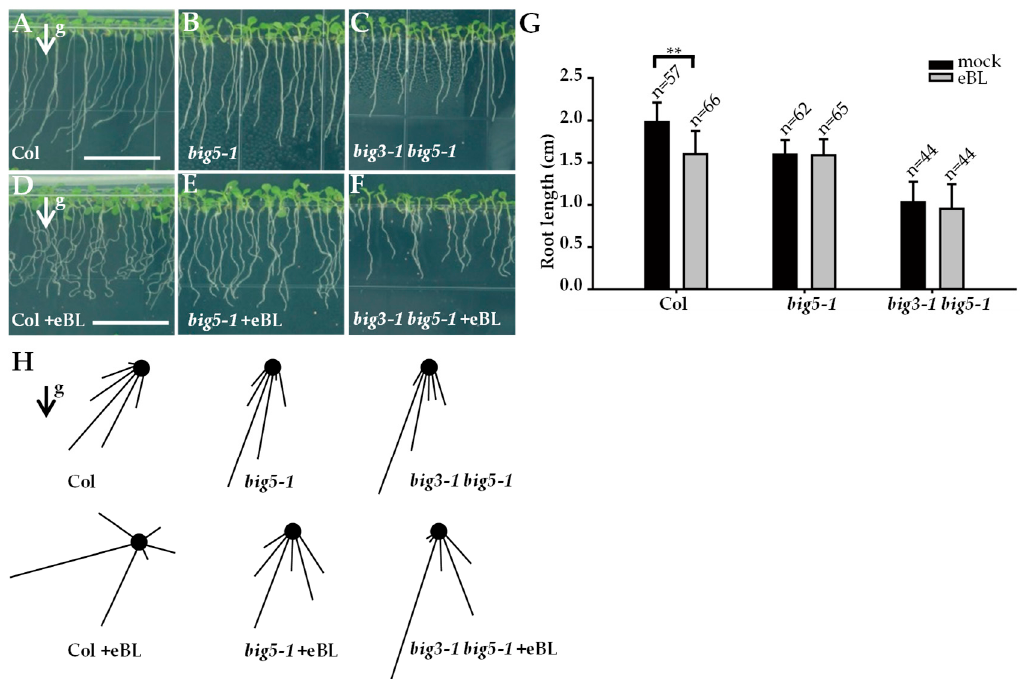
Figure 4. BIG5 and BIG3 are required for root elongation and gravitropic response. ( A – C ) Vertically grown seedlings of Col ( A ), big5-1 ( B ), and big3-1 big5-1 ( C ). ( D – F ) Seedings grown on medium supplemented with 10 nM eBL. In contrast to the twisted and significantly reduced total root length in Col ( D ), big5-1 ( E ) and big3-1 big5-1 ( F ) are insensitive to BR treatment. ( G ) Quantitative analysis of total root length. ( H ) Arrows indicate the gravity vector. Vector-bar graphs represent the degree of root tip deviation from the gravity vector. Bars = 1.5 cm; Error bars represent standard deviations, significant difference after Student’s t -test, ** p < 0.01.